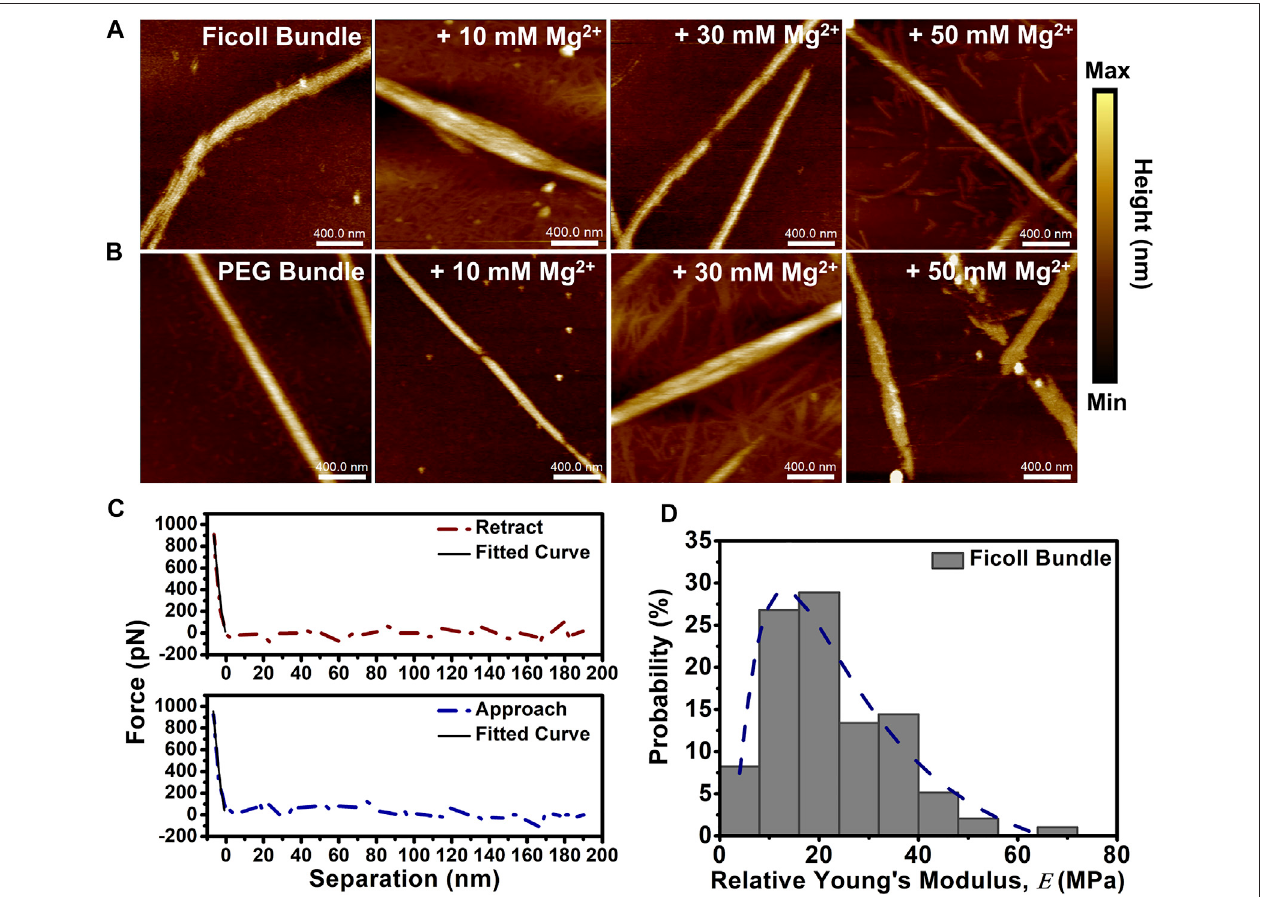
FIGURE3| Depletion-inducedactinbundleatomicforcemicroscopy(AFM)imagingandnanomechanicalanalysis. (A , B) RepresentativeAFMimagesofdepletion- induced bundles in the absence and presence of increasing (Mg 2+ ) (10 – 50 mM Mg 2+ ). (A) 20% w/w Ficoll bundles + 10 – 50 mM Mg 2+ and (B) 5% w/w PEG bundles + 10 – 50 mM Mg 2+ . Actin bundle ≈ 15 µM and scale bar (cid:2) 400 nm. (C) Representative Ficoll-induced actin bundle retract and approach force curves demonstrating the elastic behavior of the bundle; solid lines indicate fi t using Hertz model. (D) Histogram of Ficoll-induced bundle control E acquired from force curve measurements along the bundle. The distribution of E is fi t with log-normal function (dashed line). Total number of force curves analyzed N ≈